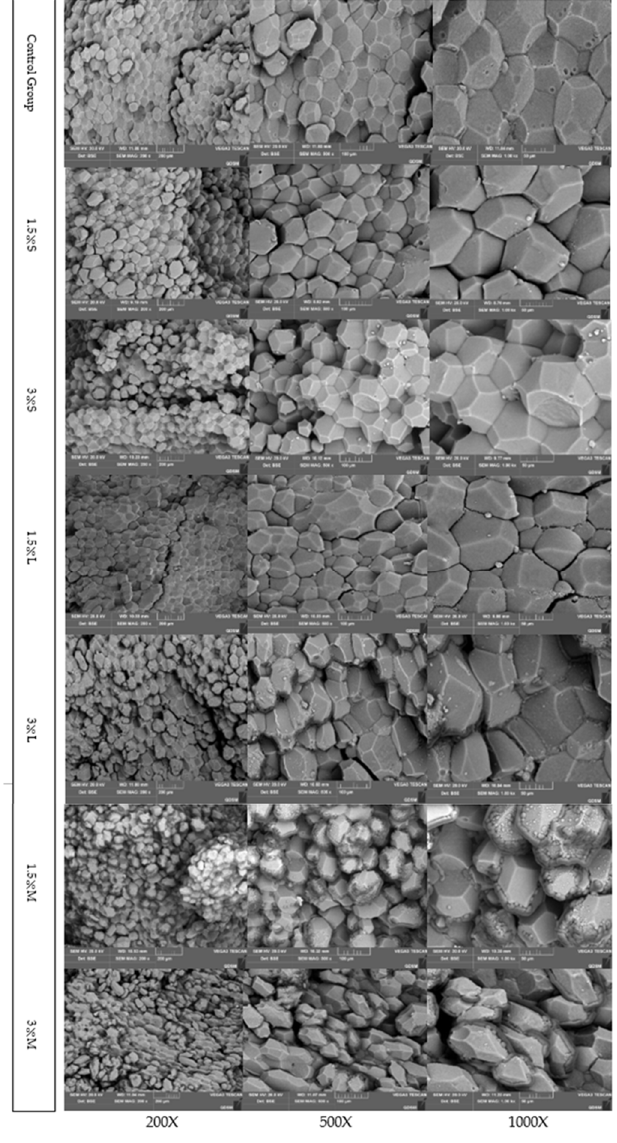
Figure 1. Micrographs of cooked yolk observed by JEM-840 at different magnifications. The abscissa indicates the different magnifications. A 1.5% S or 3% addition of 1.5% or 3% of soybean oil to the base diet, respectively. A 1.5% L or 3% addition of 1.5% or 3% of lard to the base diet, respectively. A 1.5% or 3% M: addition of 1.5% or 3% of mixed oils to the base diet, respectively.